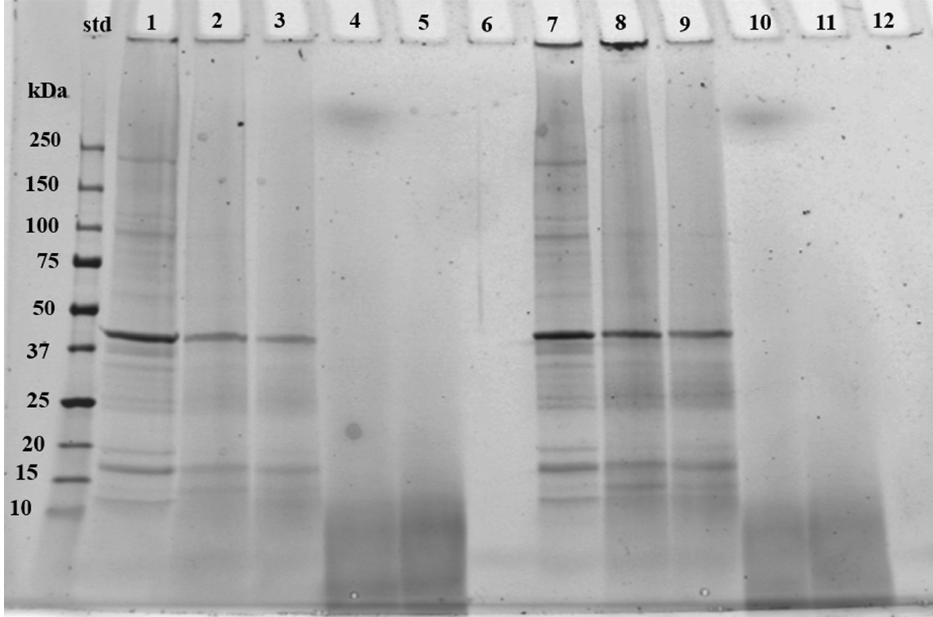
Figure 1. The reducing SDS-PAGE image of commercial fish protein concentrates, hydrolysates, and hydrolyzed collagen. To lines 1–6 was pipetted 20 µL of solution and to lines 7–12 25 µL of solution. Line numbers represent samples: 1 and 7 = CONC3, 2 and 8 = CONC1, 3 and 9 = CONC2, 4 and 10 = HYDR1, 5 and 11 = HYDR2, 6 and 12 = COLL1. Fish protein concentrates = CONC1–3, fish protein hydrolysates = HYDR1–2, hydrolyzed fish collagen = COLL1. Standard is abbreviated as